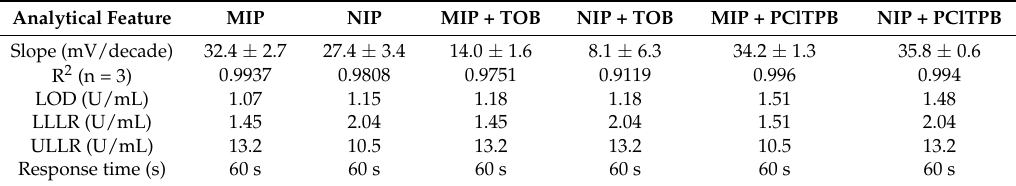
Table 5. Main analytical features of the ISEs in Cormay Serum HM, at pH 6.5.